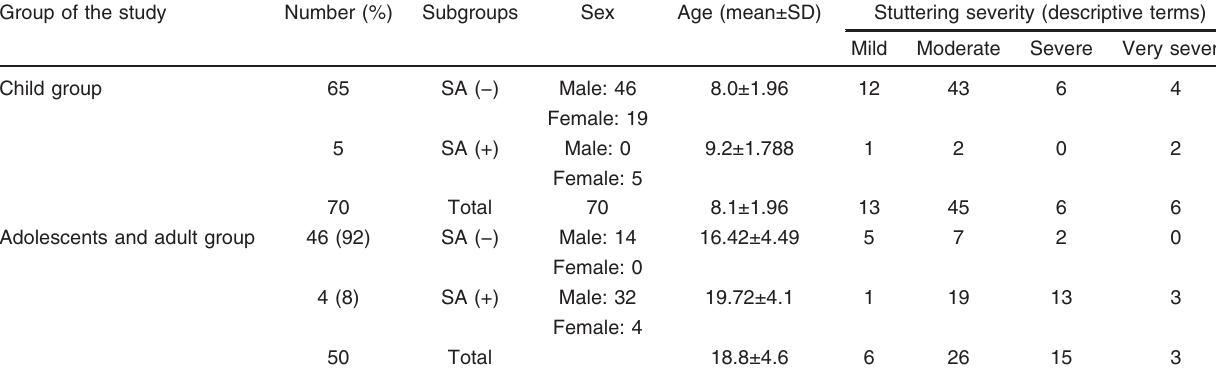
Table 4 Sociodemographic characteristics of patients within the subgroups of the main group of stutterers Group of the study